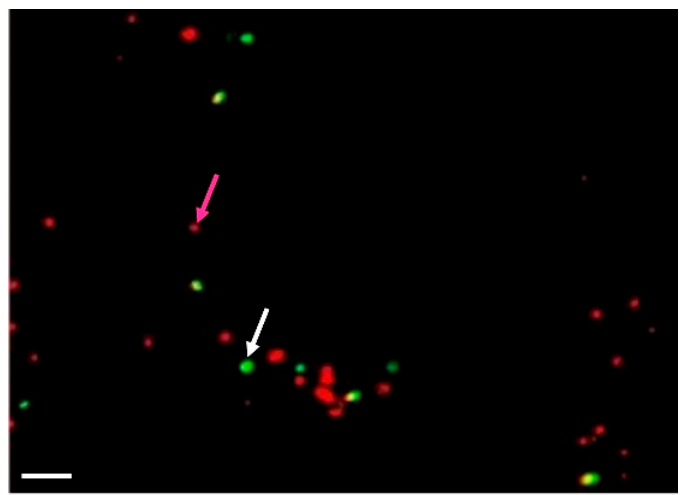
Figure 4. Detection of the cell competence to undergo the cell cycle progression in Arabidopsis shoot-derived protoplasts. 5-Ethynyl-2´-deoxyuridine (EdU) was added to the cell suspension at 12 h after isolation. The cells were fixed at 36 and 60 h after isolation, and the nuclei were isolated and subjected to the standard procedure for EdU detection. Nuclei are red; EdU stained nuclei are in green. White arrow marked positive nuclei, while magenta arrow— negative. Scale bar — 20 µm.